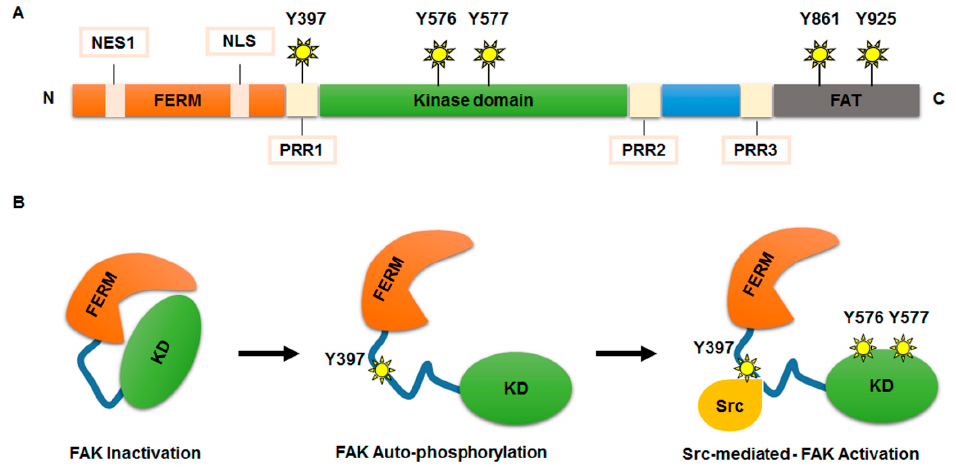
Figure 1. FAK protein structure and activation. ( A ) Schematic representation of the FAK protein structure. The N-terminal domain comprises a FERM domain, a nuclear export sequence 1 (NES1), a nuclear localization sequence (NLS) a proline-rich region (PRR1) and a 397-tyrosine auto-phosphorylation site (Y397). The central kinase domain contains Y576/Y577 phosphorylation sites, crucial for the kinase activity of FAK. The C-terminal domain includes a focal adhesion targeting (FAT) sequence and two proline regions (PRR2 and PRR3), which are important for binding with several molecular regulators and effectors. In C-terminal domain Y861 and Y925 phosphorylation sites are also included; ( B ) model of FAK activation. FERM domain binds to the central kinase domain maintaining FAK into an inactive form. Auto-phosphorylation at Y397 site removes FAK inhibition. Src kinase binds FAK at phosphorylation Y397 site generating a FAK-Src signalling complex, which contributes, after phosphorylation of Y576 and Y577 residues, to full activation of FAK activity.